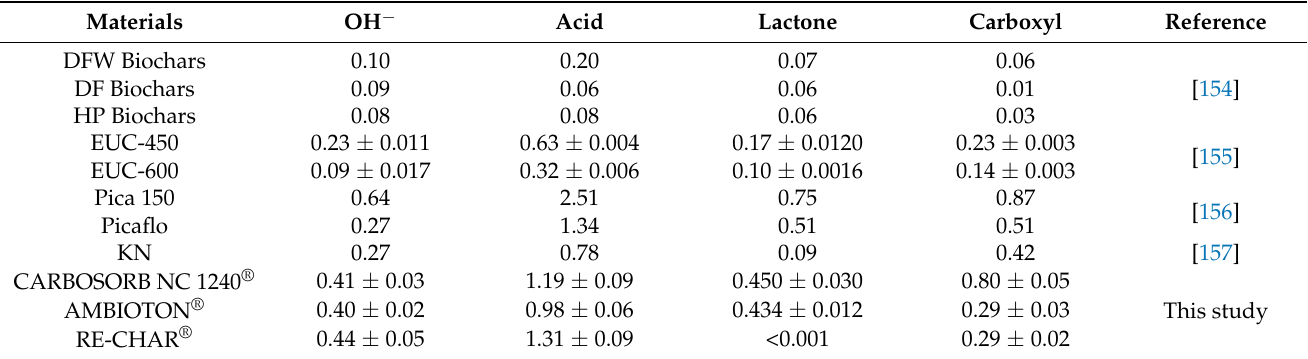
Table 9. Boehm analysis (mmol/g) performed for the carbonaceous substances.